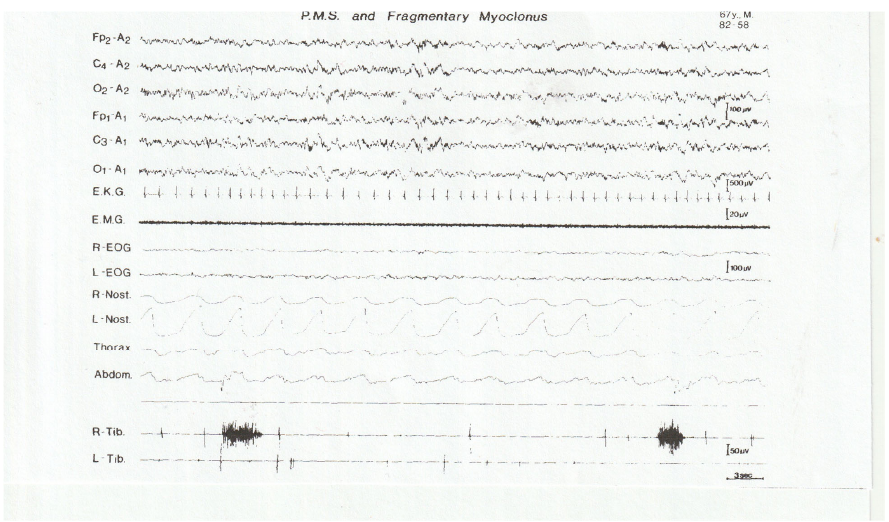
Figure 28. Excessive fragmentary myoclonus associated with periodic leg movements in his right leg in a 56-year-old patient complaining of excessive daytime sleepiness. (Reproduced with permission from Broughton R, Tolentino MA and Krelina M. Excessive fragmentary myoclonus in NREM sleep: a report of 38 cases. Electroenceph clin Neurophysiol 1985; 61:123–133; published by Cambridge University